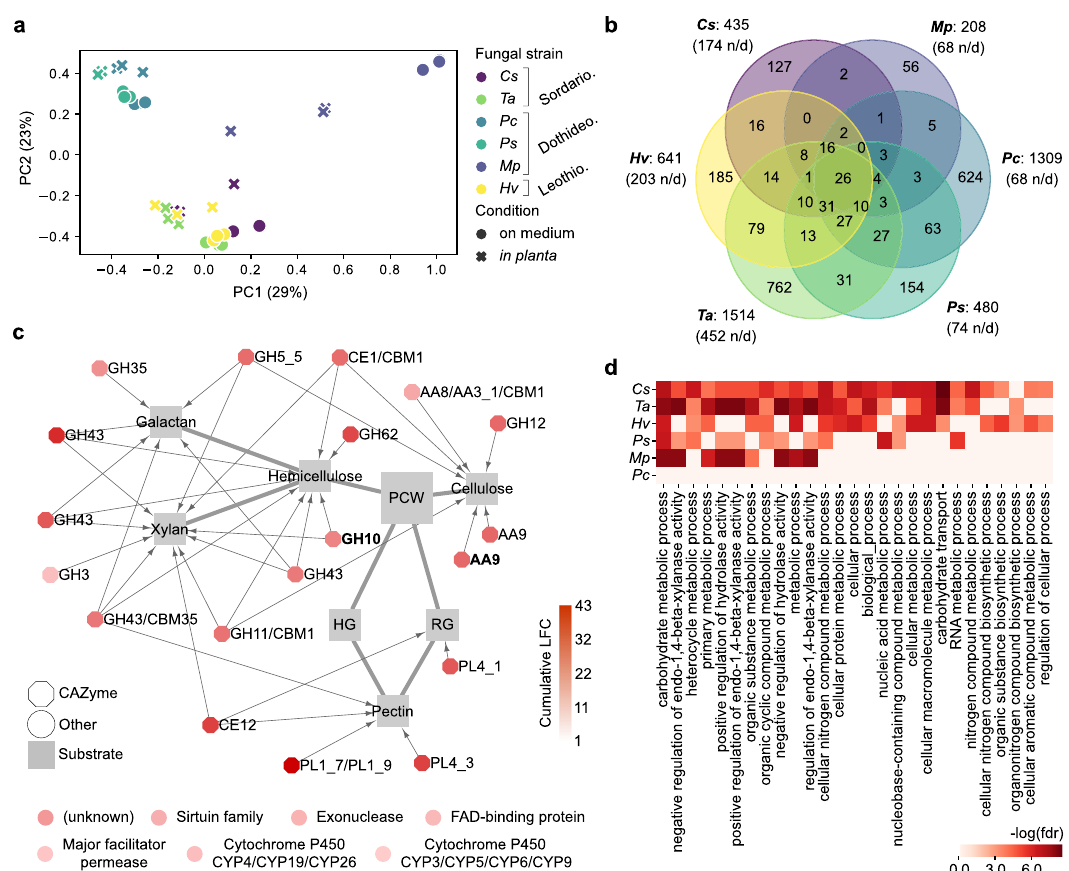
Fig. 5 Comparative transcriptomics identi fi ed a core set of PCWDE-encoding genes induced in A. thaliana roots by diverse mycobiota members. a PCoA plot of Bray-Curtis distances calculated on gene family read counts from fungal transcriptome data on medium and in planta. Cs = Chaetomium sp. 0009 , Mp = Macrophomina phaseolina 0080 , Pc = Paraphoma chrysantemicola 0034 , Ps = Phaeosphaeria sp. 0046c , Ta = Truncatella angustata 0073 , Hv = Halenospora varia 0135 . b Venn diagram showing the number of fungal gene families over-expressed in planta. It highlights 26 families commonly over-expressed by all six fungi (n/d: non-displayed interactions). c Commonly over-expressed gene families in planta ( n = 26), which include 19 plant cell- wall degrading CAZymes (octagons) linked to their substrates, as described in literature 32,84 . The two CAZyme families highlighted in bold were identi fi ed as potential determinants of endophytism (SVM-RFE, see Fig. 3a). The seven remaining (non-CAZyme) families are shown below the network. d Individual GO enrichment analyses performed on the genes over-expressed in planta vs. on medium by each fungal strain (GOATOOLS 51 , FDR <